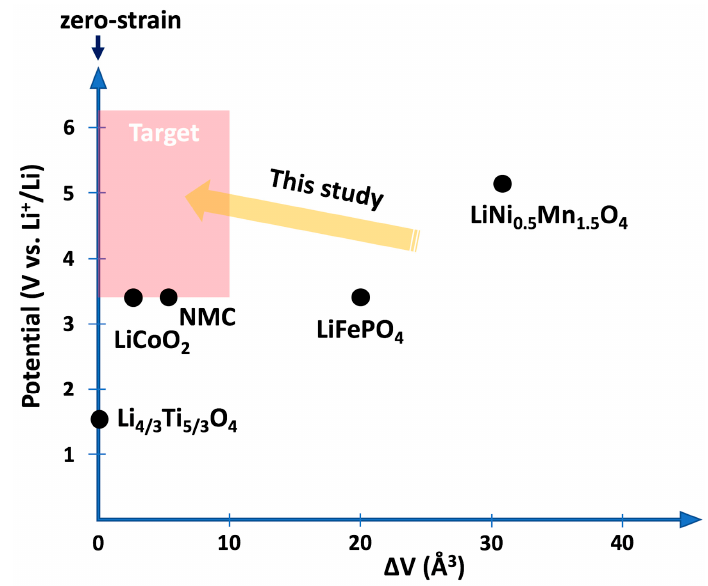
Figure 1. Li chemical potentials and volume changes of candidate cathode materials. The shaded area marks the target materials with a much lower volume change than the benchmark LiNi 0.5 Mn 1.5 O 4